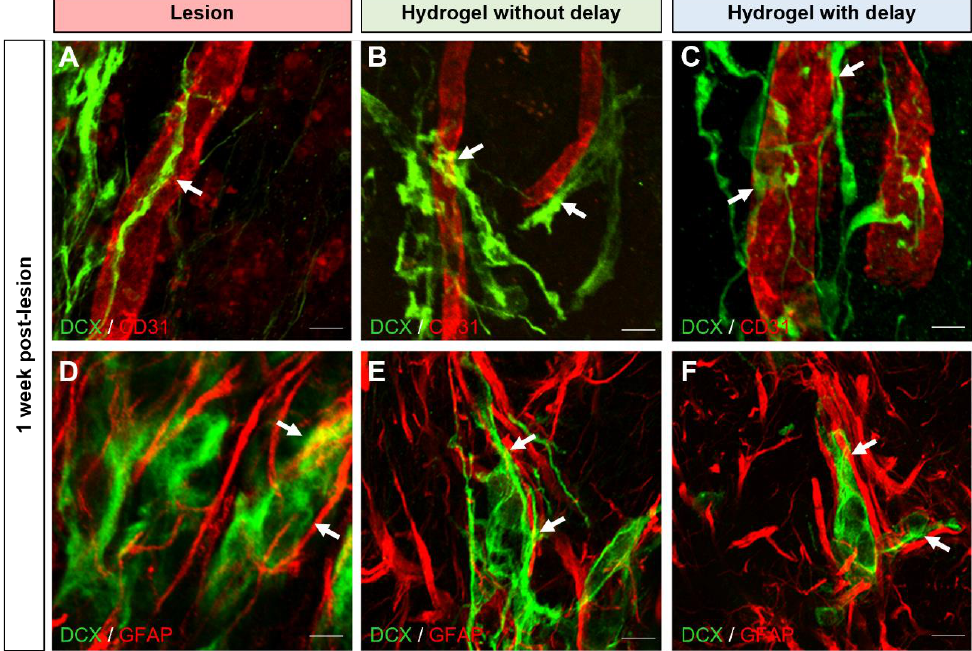
Figure 6. Mode of neuroblast migration towards cortical lesion site. ( A – F ) Representative immuno- fluorescence staining of neuroblasts labeled with DCX (green) and blood vessels with CD31 (( A – C ), red) or astrocytes with GFAP (( D – F ), red), in lesioned ( A , D ) or implanted mice without delay ( B , E ) or with delay ( C , F ). Dashed lines indicate hydrogel localization. The squares indicate the area of magnification. Scale bar: 20 μm. magnification. Scale bar: 20 µ